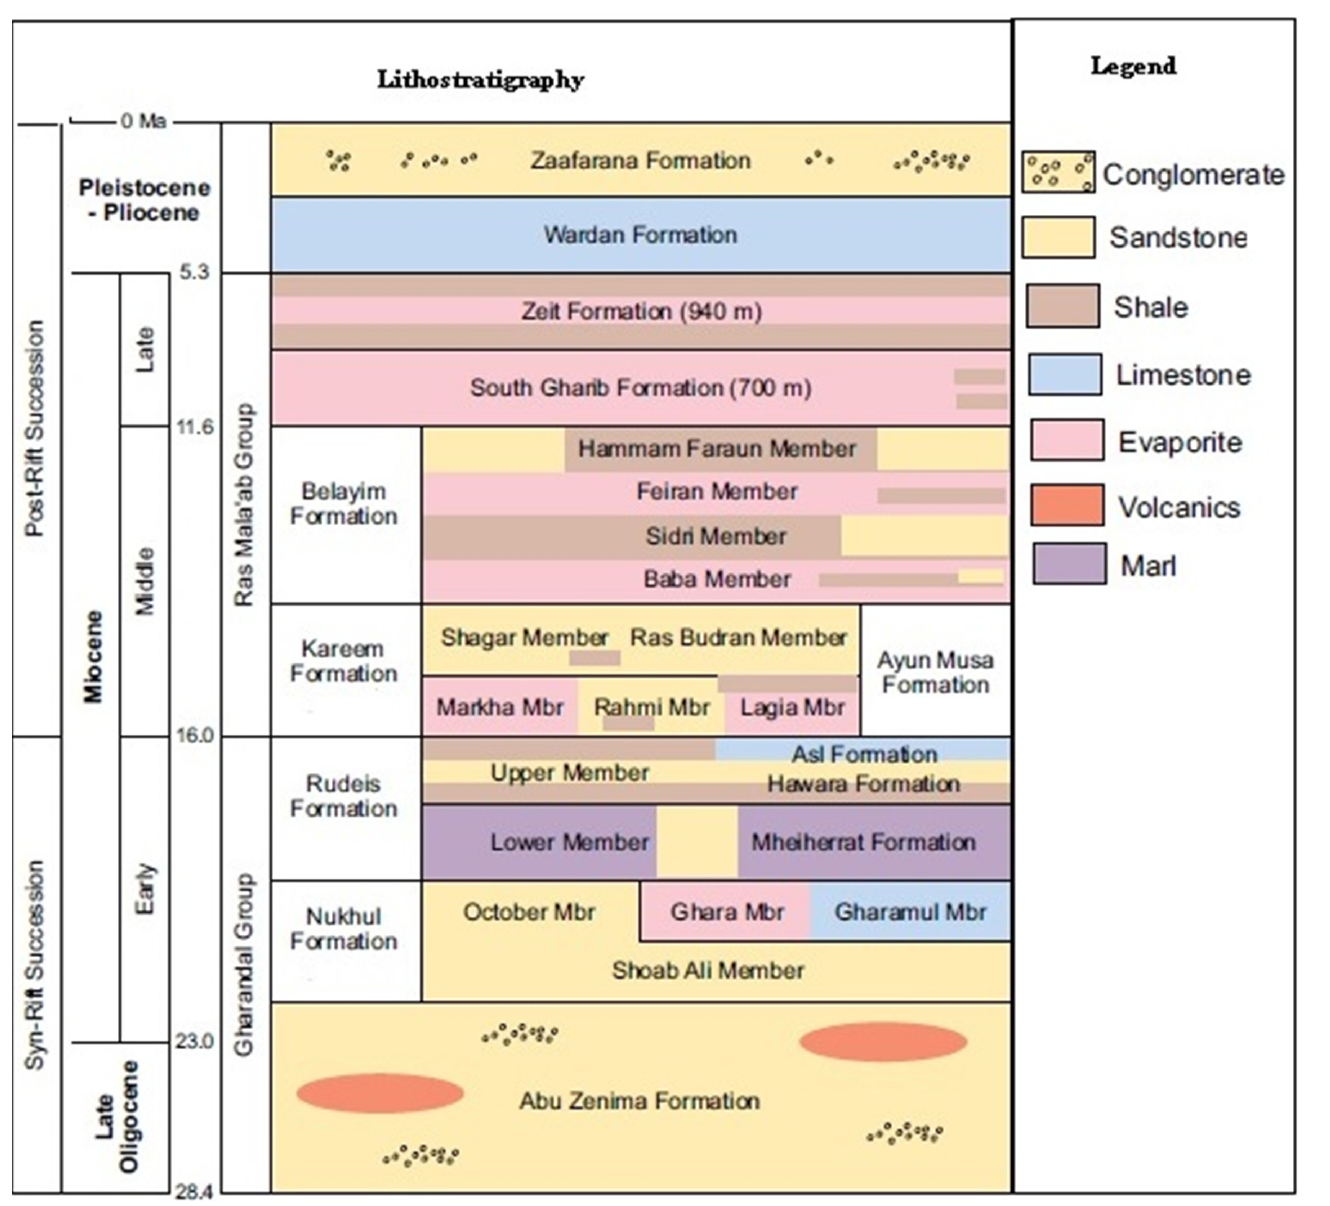
Figure 2. Lithostratigraphic column of the syn-rift and post-rift sediments in the El Morgan Field.